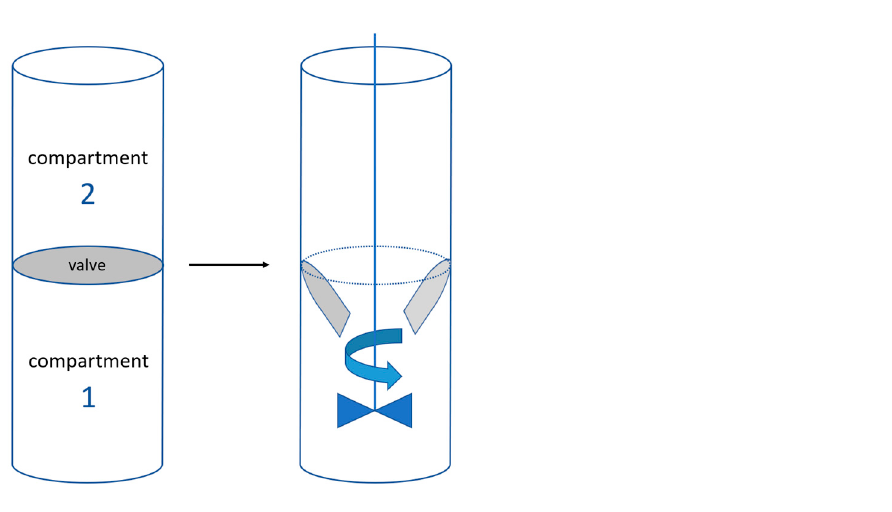
( c ) Figure 3. Environmental Scanning electron microscope (ESEM) analyses of the di ff erent loose doughs. ( a ): control dough exhibiting smooth starch granules and sucrose crystals embedded in a compact matrix, ×150, ( b ): maltitol dough exhibiting smooth starch granules and maltitol crystals embedded in a powdery matrix, ×150, ( c ): sorbitol dough magni fi ed at ×250 to reveal localized sor- bitol fl akes among smooth starch granules embedded in a slightly powdery matrix. 3.1.3. Dough Pieces A second observation was made on dough pieces, that is to say, after the loose dough rested for 30 min and passed through the rotative press. The dough pieces were observed in environmental mode with the same scanning electron microscope at +4 °C between 610 and 730 Pa.